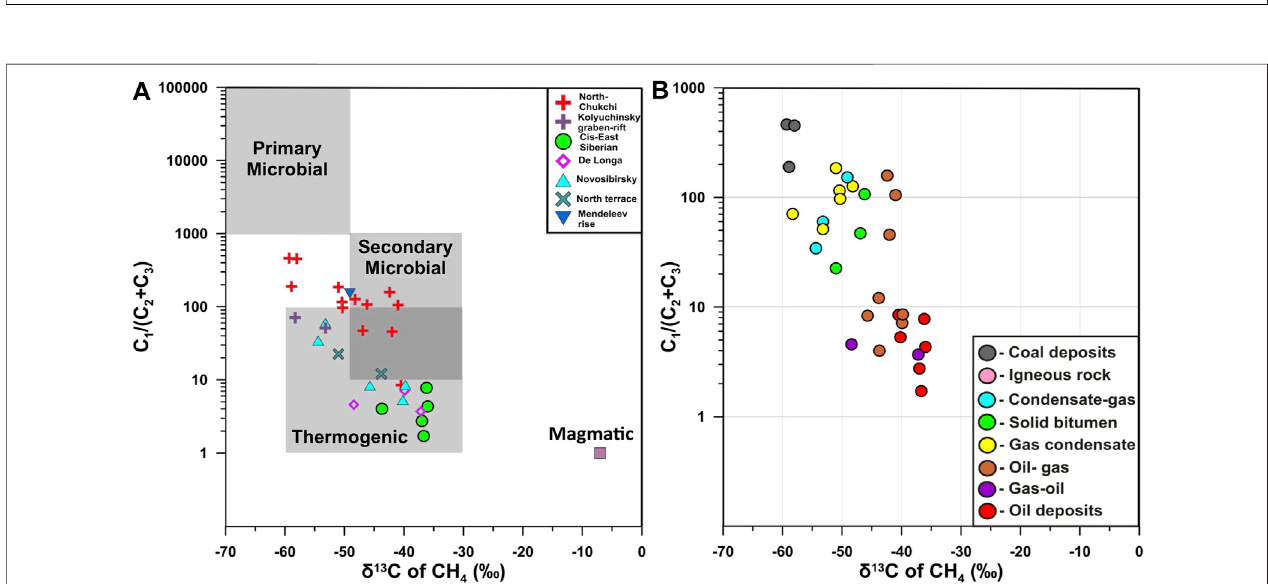
FIGURE 6 | Bernard diagram (after Bernard et al., 1976). (A) Bernard diagram versus author ’ s gas genetic groups (B) . Genetic groups are the same such as in Figure 5 .